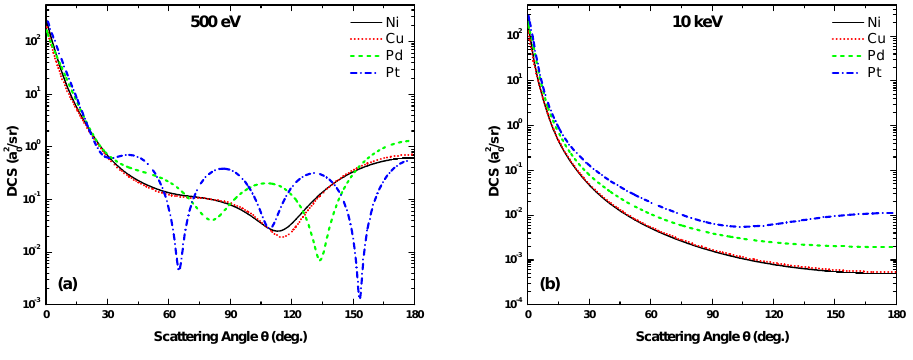
Figure 7. Angular dependence of the differential cross-sections for 100 eV electron scattering from ( a ) Ni 58 , ( b ) Cu 63 , ( c ) Pd 108 , and ( d ) Pt 196 . Experiment: Madison el al. [36] and Trajmar et al. [37]. Theory: Present OPM (——), Jablonski et al. [35], Czyzewski et al. [38], and Msezane and Henry [14].